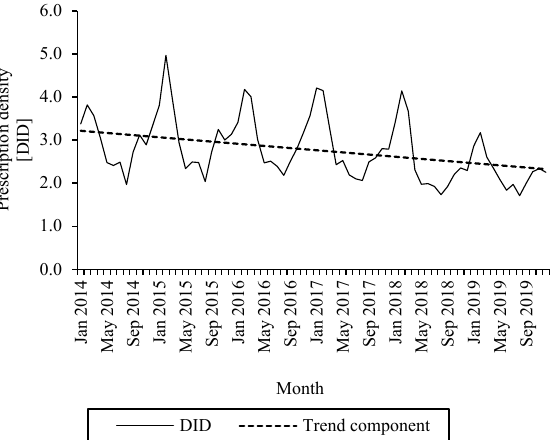
Figure 2. Monthly cephalosporin DID during 2014–2019 in Germany and calculated trend. Table 3. Trends for monthly cephalosporin DID during 2014–2019. Abbreviations: DID 2014 , Average DID in 2014; DID 2019 , Average DID in 2019; Δ, percentage difference between 2019 and 2014 values; Avg, average monthly change in DID. In order to account for the different alpha levels for the individual federal states due to the Bonferroni-Holm method, Avg that are significantly different from zero are marked with *; R 2 , coefficient of determination for the applied model.